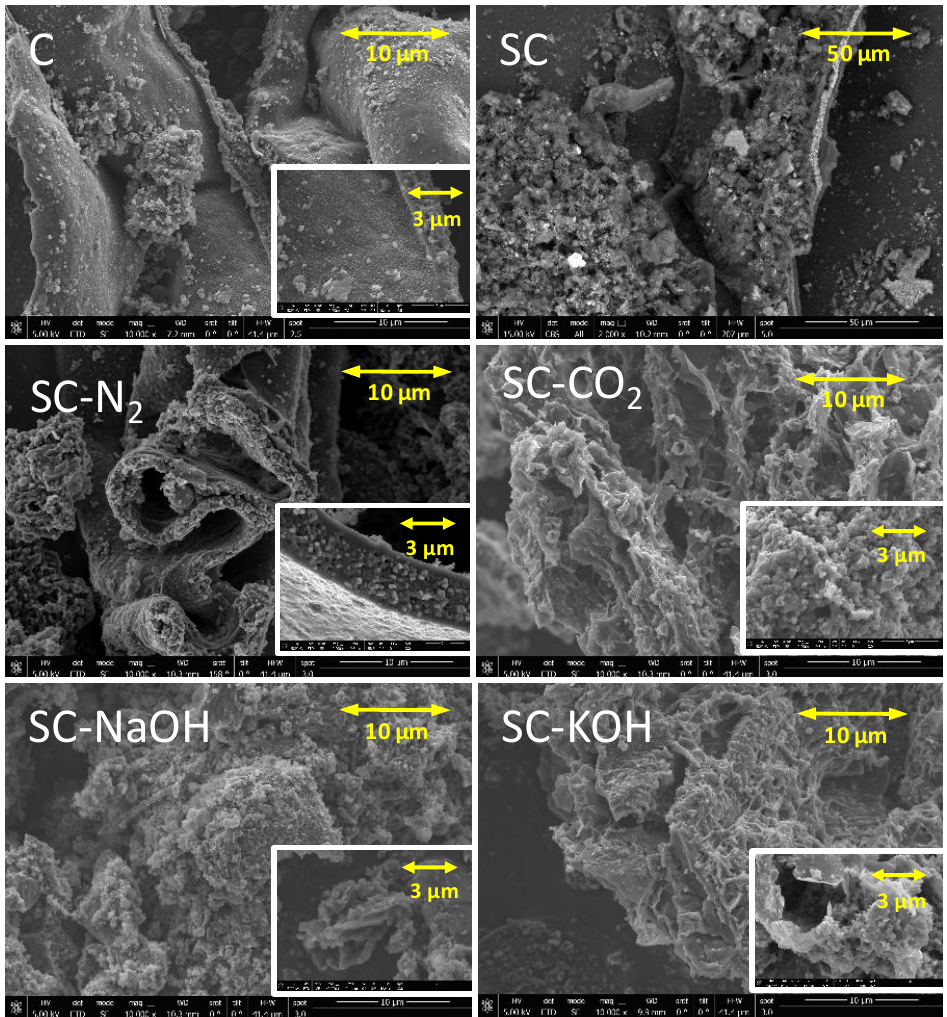
Figure 2. SEM micrographs of the char from plastic pyrolysis before and after activation.